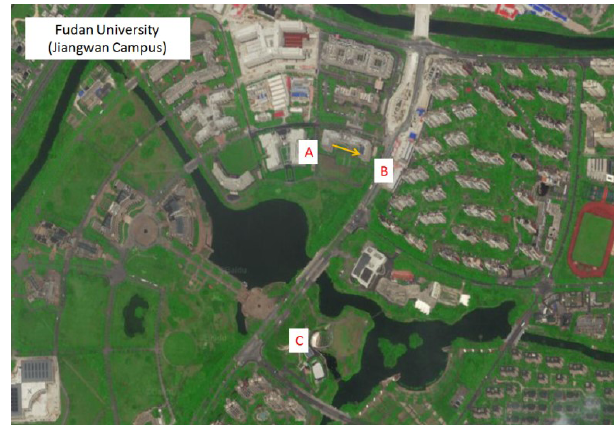
Figure 5. Field measurement sites of DOAS and online VOCs, A is the transmitting telescope, B is the receiving telescope, and C is the online VOCs, and the yellow arrow is the light path of the DOAS. This map is sourced from ©